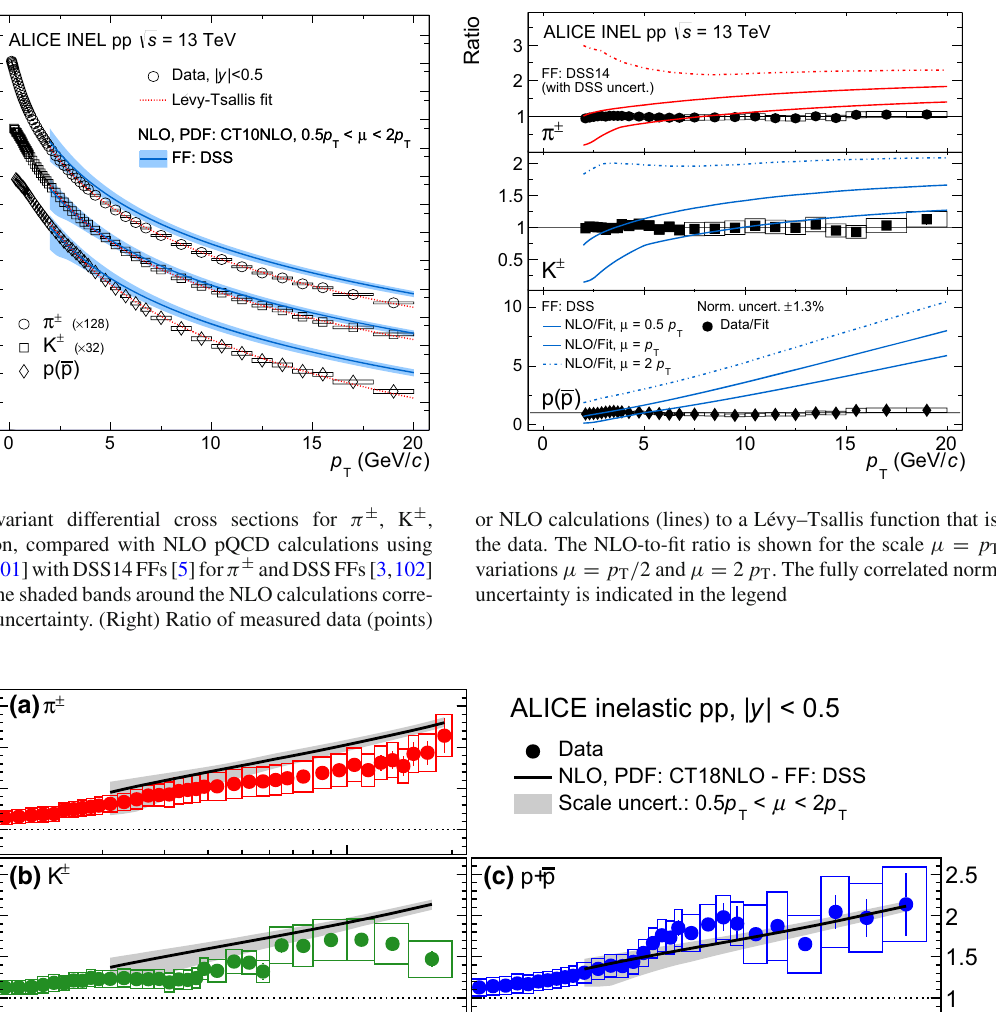
leading order (NLO) pQCD calculation using DSS fragmentation func- √ s = 13 TeV to those tions[103].Statisticalandsystematicuncertaintiesareshownasvertical error bars and boxes,